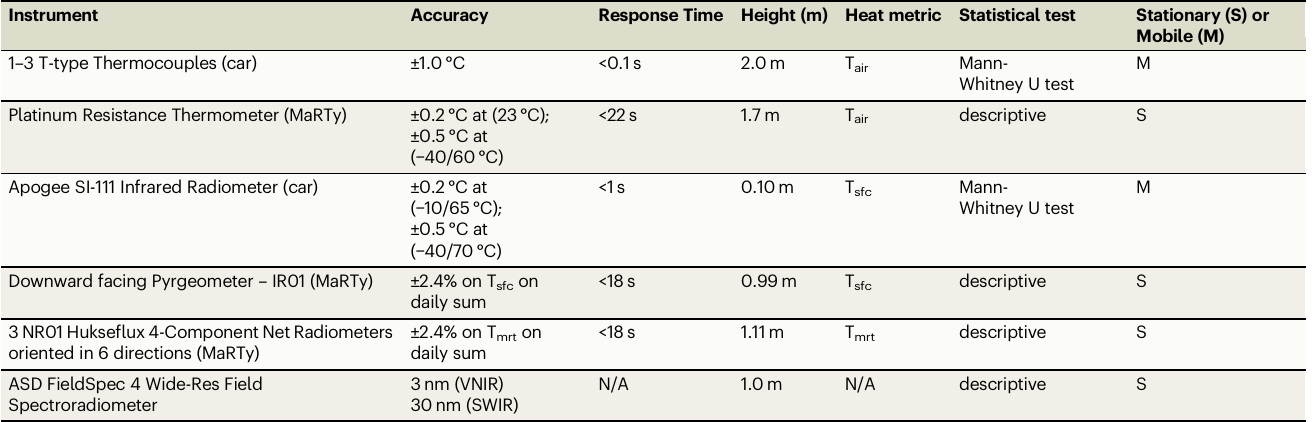
Table 1 | List of instruments used to measure each heat metric and the solar re fl ectivity of the RP